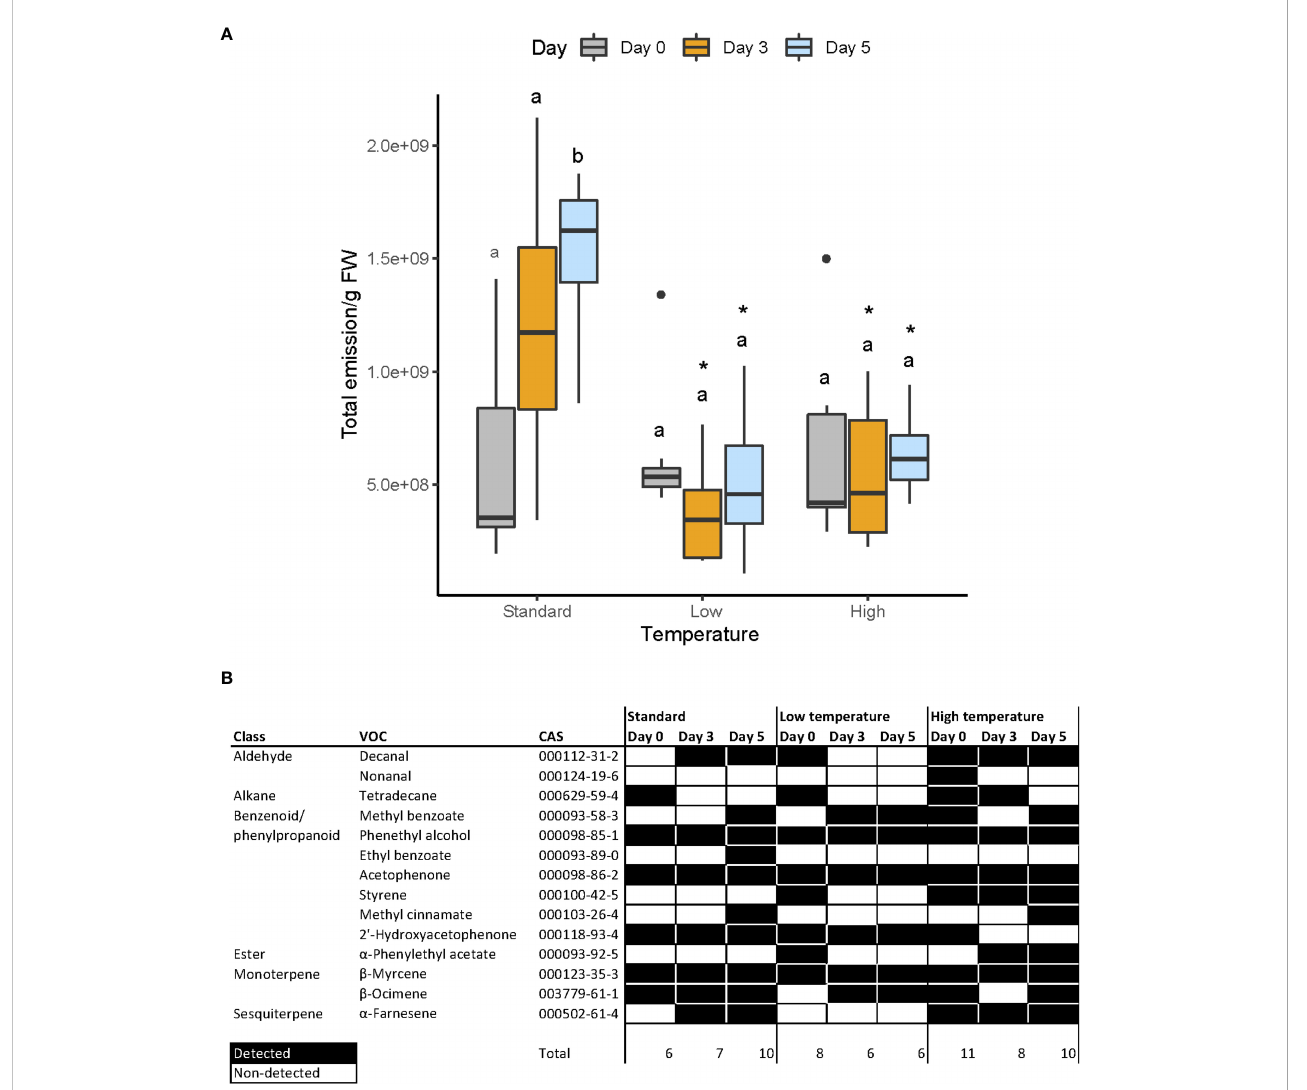
FIGURE 4 (A) Total fl oral scent emitted by fl owers. Letters over bars indicate differences across each group (see Supporting Information, Table S5) whereas asterisks denote differences across fl ower stages (see Supporting Information, Table S6), (B) Constitutive scent pro fi le of snapdragon fl owers under three different conditions (standard, low and high temperatures) and at three development stages, expressed as days after anthesis. This pro fi le comprises those volatiles that were present in all samples from each group. Black and white cells indicate constitutive and non-constitutive compounds,